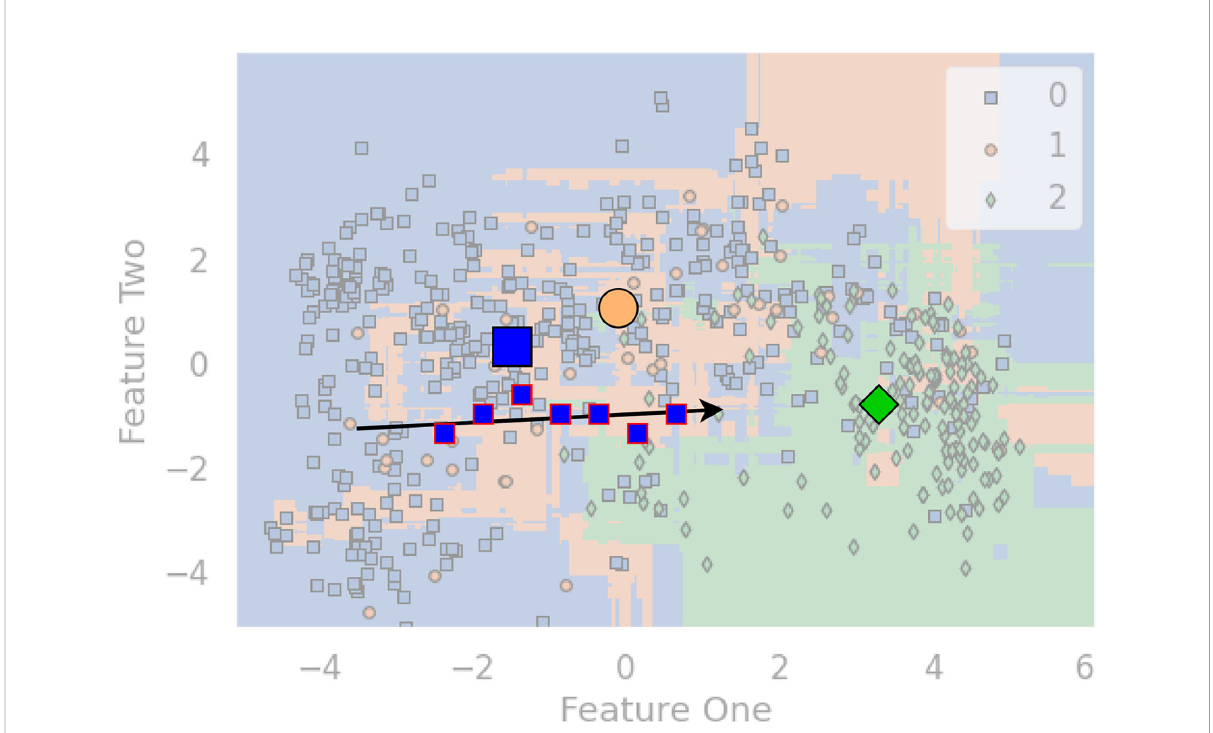
FIGURE 1 An example diagram that showcases the distance-based method for HBV malignant progression